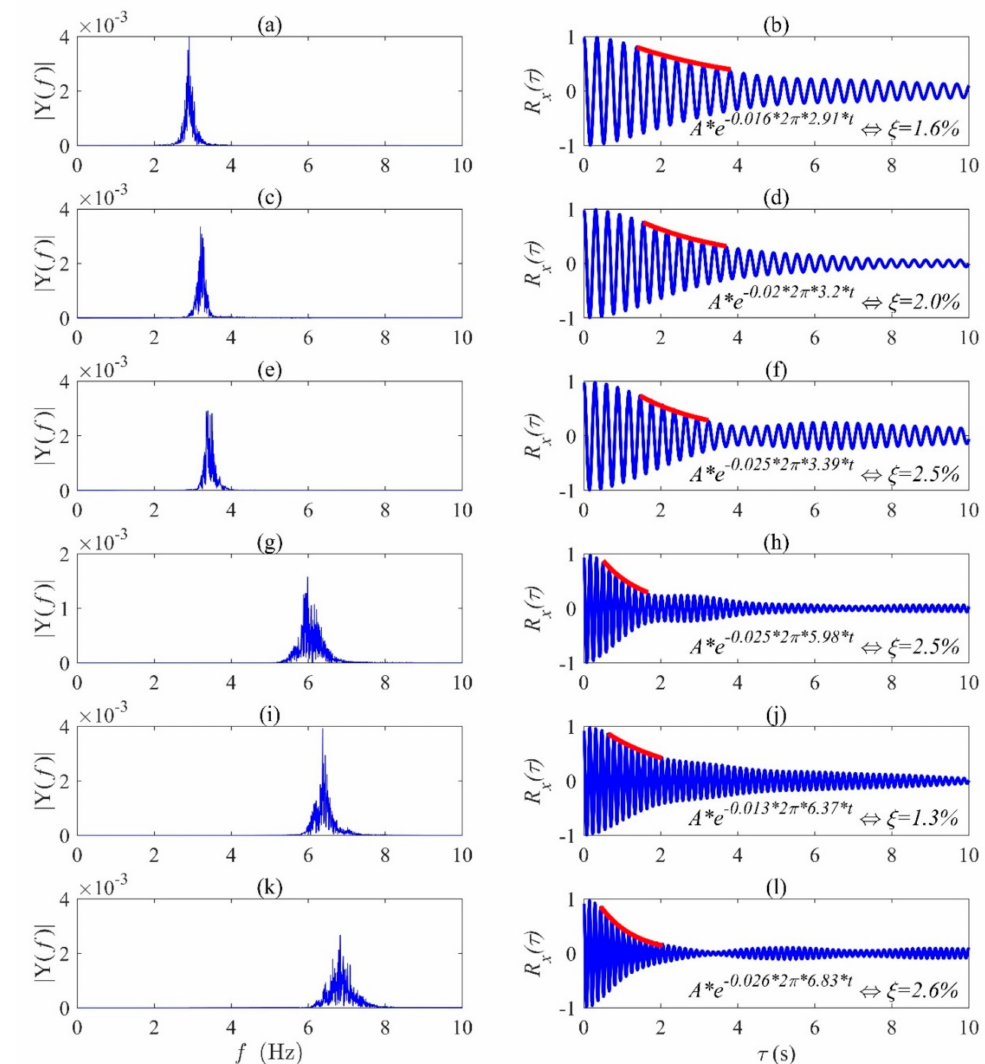
Figure 8. Fourier spectra and ACF of IMFs extracted from the middle sensor of test #A-2, respectively: ( a , b ) IMF1; ( c , d ) IMF2; ( e , f ) IMF3; ( g , h ) IMF4; ( i , j ) IMF5; ( k , l )